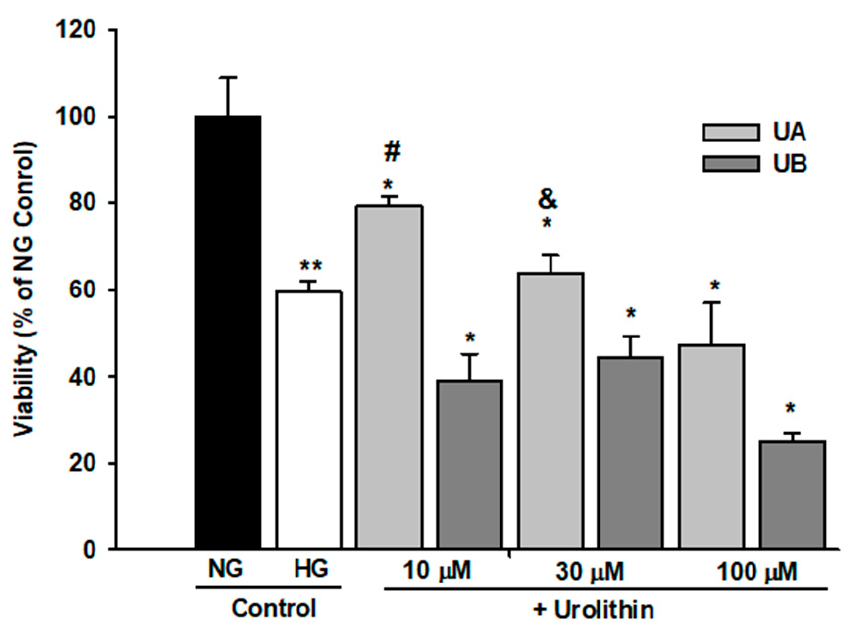
Figure 4. Urolithins A and B differentially affected the viability of podocytes exposed to high glucose. Podocytes cultured in high glucose (25 mM, HG) were incubated for 48 h with varying concentrations of urolithins. Control cells were incubated with vehicle (DMSO) alone. Results show mean ± SEM. ANOVA and the Student’s t -tests were used to calculate p values. * p < 0.05 vs. NG Control, & p < 0.05 vs. 30 µ M UB, ** p < 0.01 vs. NG Control and vs. 100 µ M UB, # p < 0.005 vs. HG Control and vs. 10 µ M UB. Each MTT test was performed in quadruplicate ( n = 4).